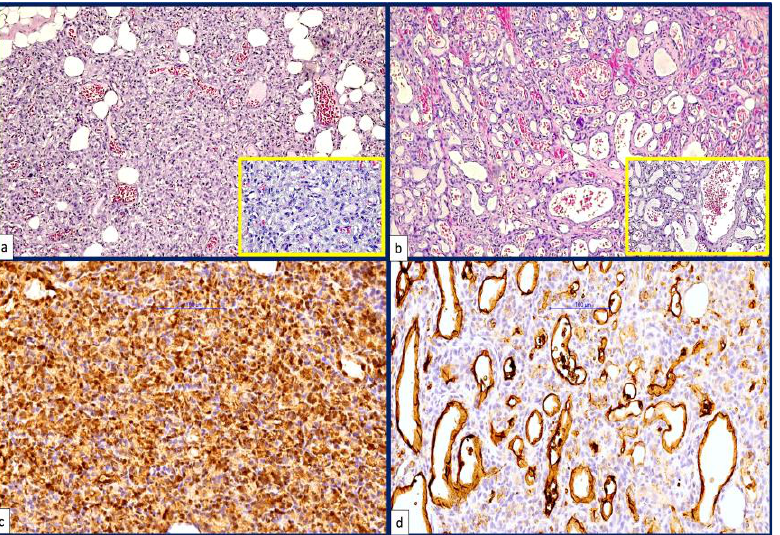
Figure 2. Histopathology and immunohistochemistry of proliferating versus involuting hemangioma. ( a ) Microscopically, a proliferating hemangioma is defined by the proliferation of vascular structures with lobular arrangement, with the lobules delineated by fibrous septa. The vascular structures have a predominantly small caliber, forming solid masses of proliferating cells. ( b ). Involuting hemangioma showing proliferation of vascular structures of variable caliber, some of them highly dilated and lined with flattened endothelial cells. Bands of fibrosis are identified as dissecting tumor